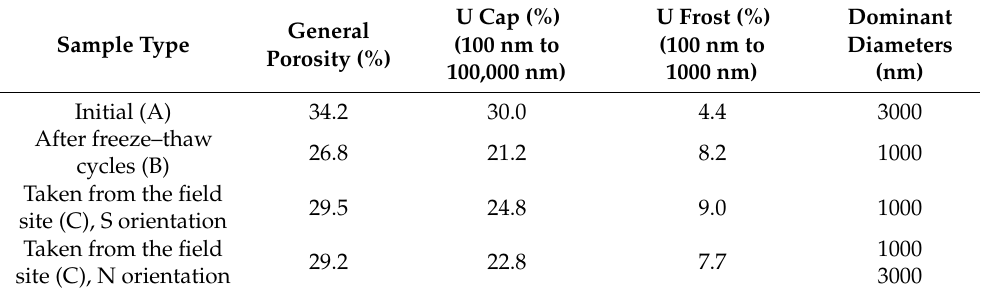
Figure 9. Integral curves of pore distribution for mineral-based plaster: ( a ) full measuring range; ( b ) pore range related to freeze–thaw durability (from 100 nm to 1000 nm). Table 2. Porosity test results.